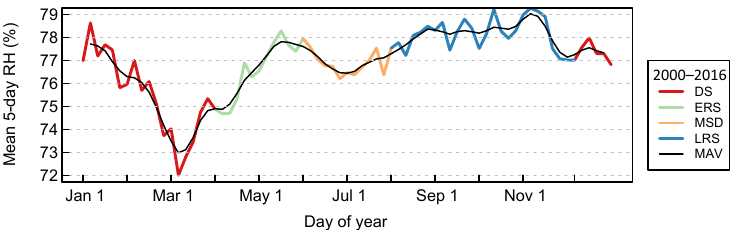
Figure 5. Day of year mean values for relative humidity (RH) averaged over all six regional airport stations (ASOS, does not include Luquillo Experimental Forest data). The colors show the 5-day means during the winter dry season (DS), early rain season (ERS), midsummer dry season (MSD), and late rain season (LRS). The black line is the 15-day moving average (MAV) for the 2000–2016